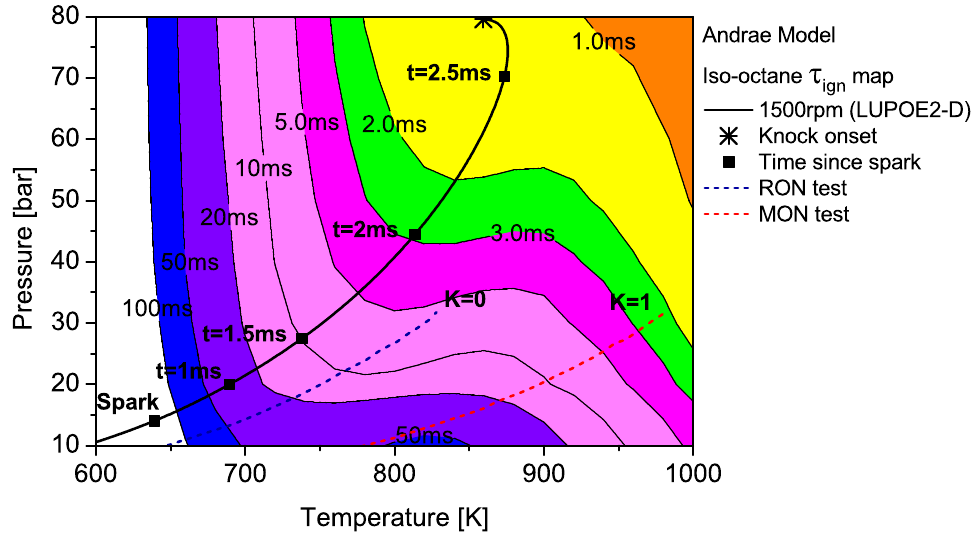
Figure 7. The τ ign contour map of iso-octane as predicted by the Andrae model superimposed by the unburned zone p − T history of LUPOE2-D and typical RON/MON